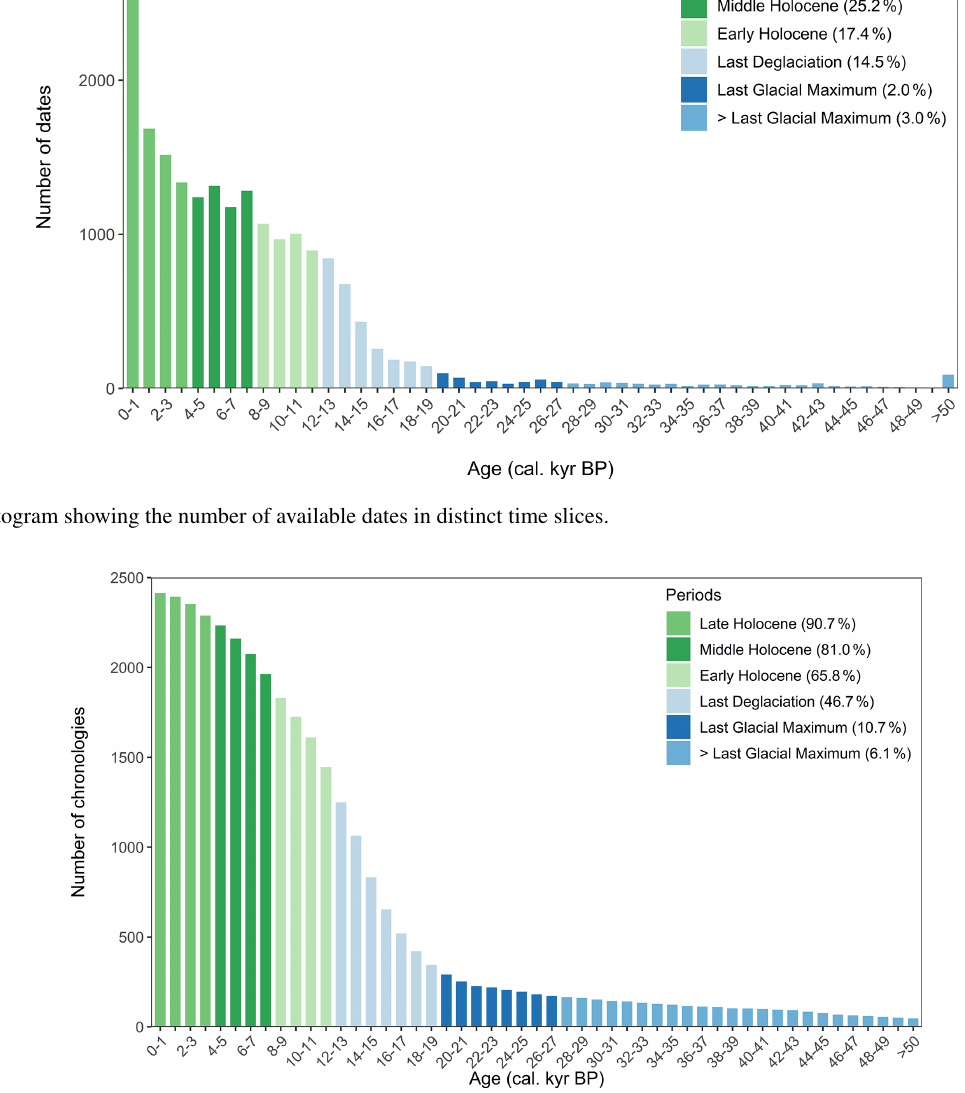
Figure 5. Histogram showing the number of available chronologies in distinct time